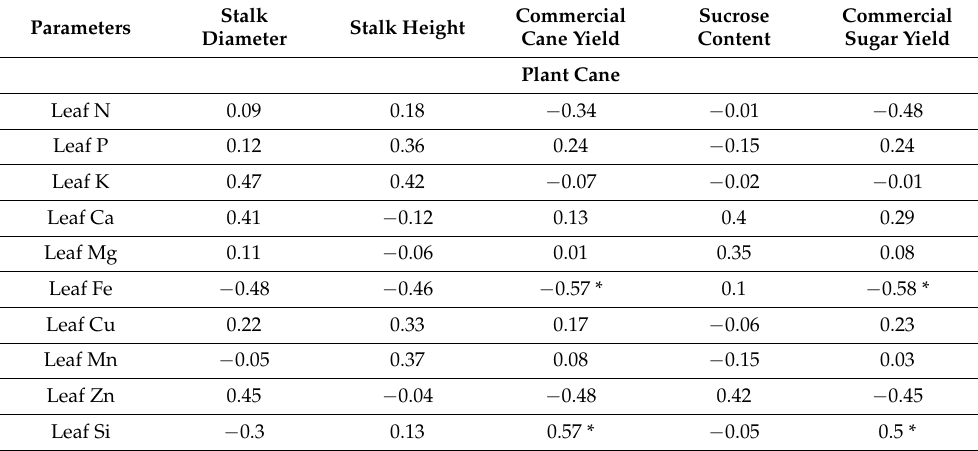
Table 6. Spearman correlation coefficients between yield parameters and leaf nutrient concentrations for sugarcane over the three crop